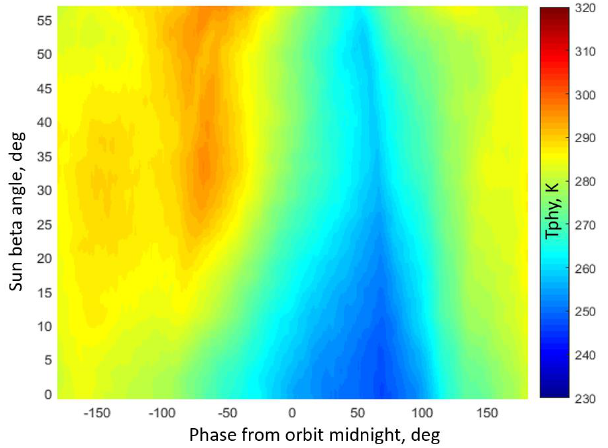
Figure 7. TMI’s Main Reflector physical temperature (yaw 0° and post-boost altitude = 403